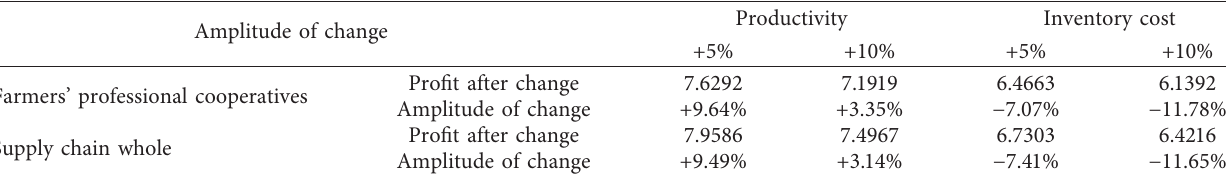
Table 7: Sensitivity analysis results-changes in productivity and inventory cost.